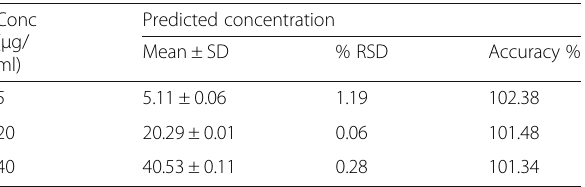
Table 3 Accuracy data for the developed bio-analytical method for naringenin in rat brain tissue